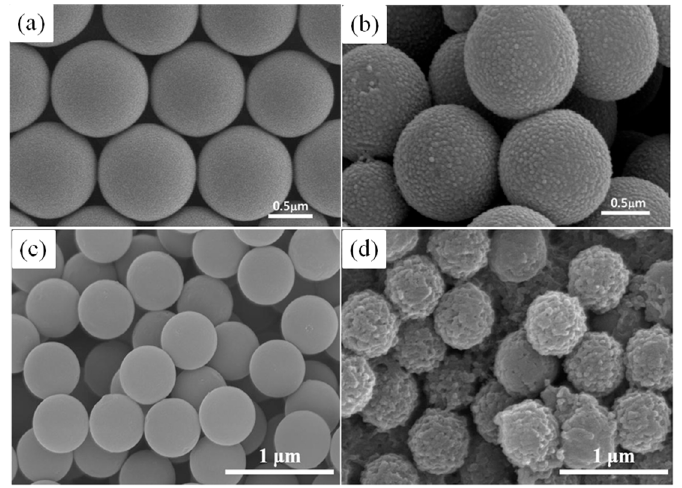
Figure 7. SEM images of PS and PS/PANI synthesized by ( a , b ) Liu et al. [126] (Copyright The Royal Society of Chemistry, 2011) and ( c , d ) Piao et al. [127] (Copyright Elsevier, 2017).